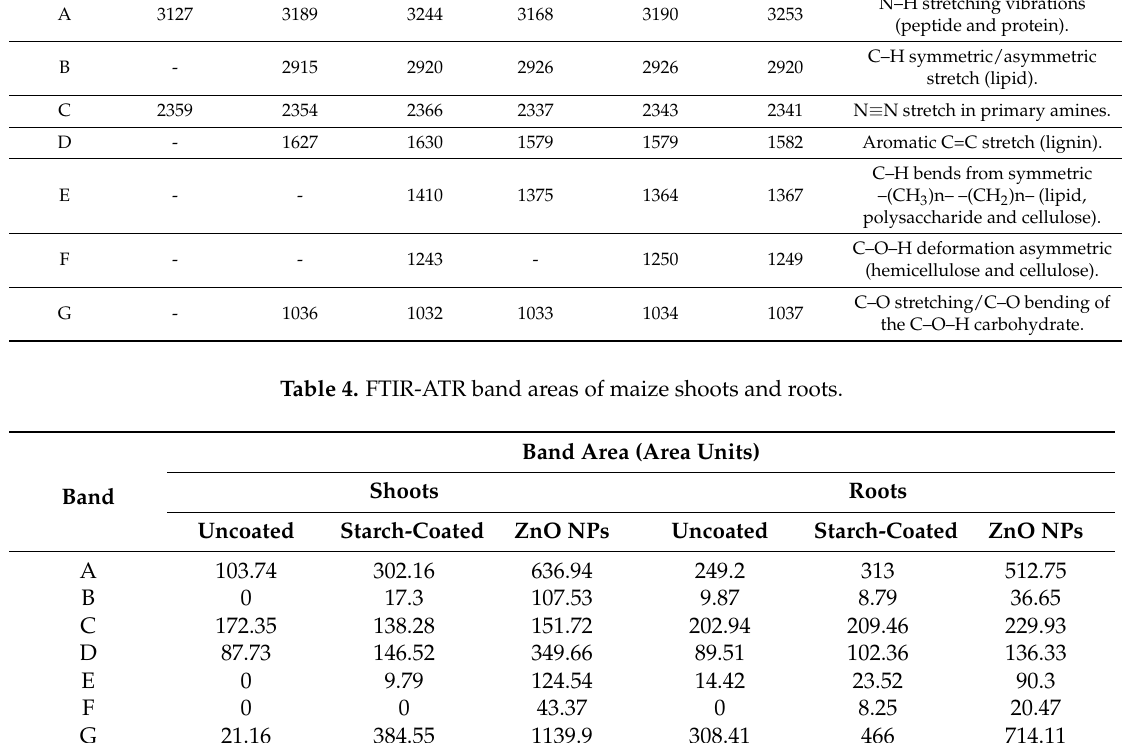
Figure S1: Comparative FTIR spectra of (a) maize seedling shoot, and (b) root